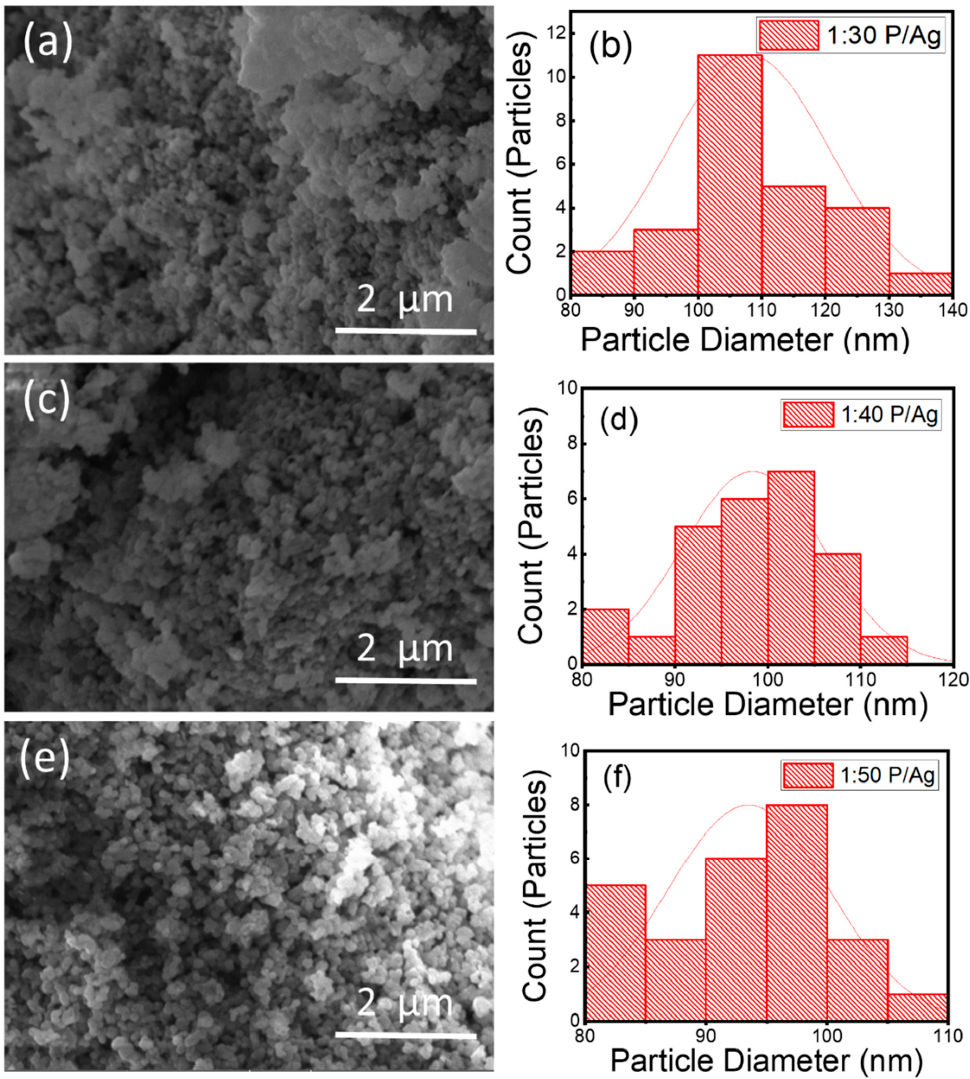
Figure 2. SEM images and particle size distributions of green synthesized Ag/Ag 2 O NPs with different volume ratios: ( a , b ) 1:30 P/Ag, ( c , d ) 1:40 P/Ag, ( e , f ) 1:50 P/Ag .